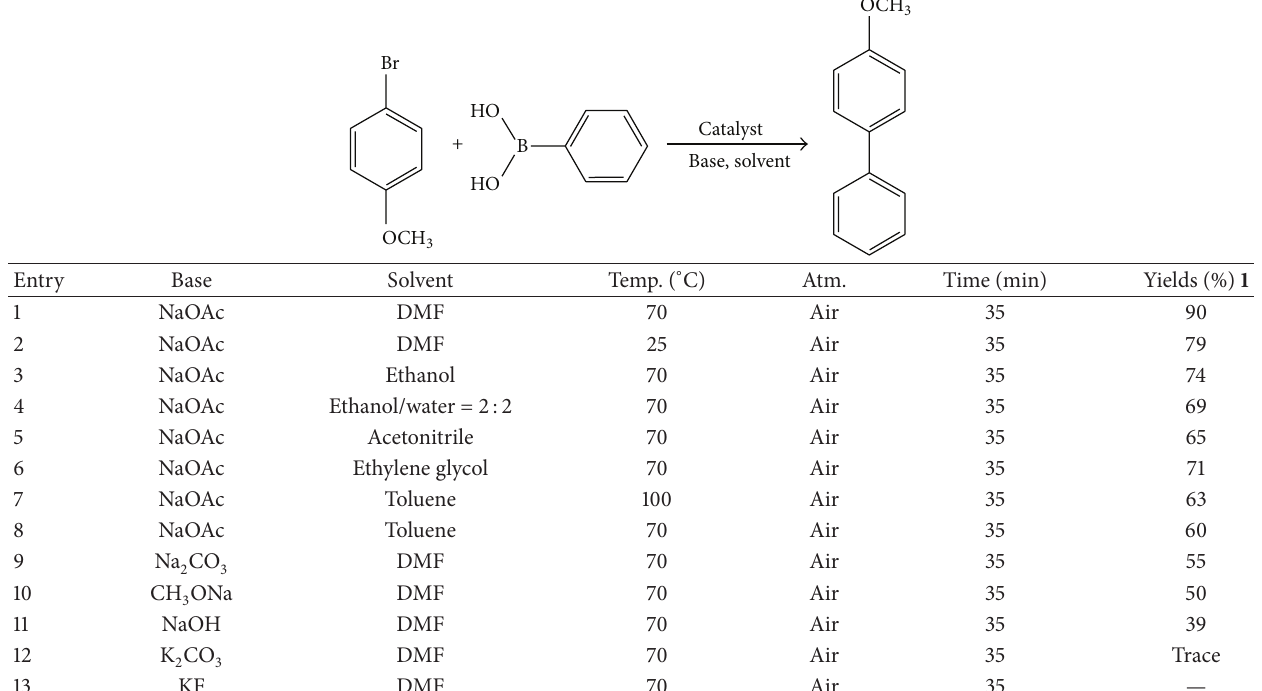
Table 5: The effect of base and solvent on complex 1 catalyzed Suzuki reaction of 4-bromoanisole with phenylboronic